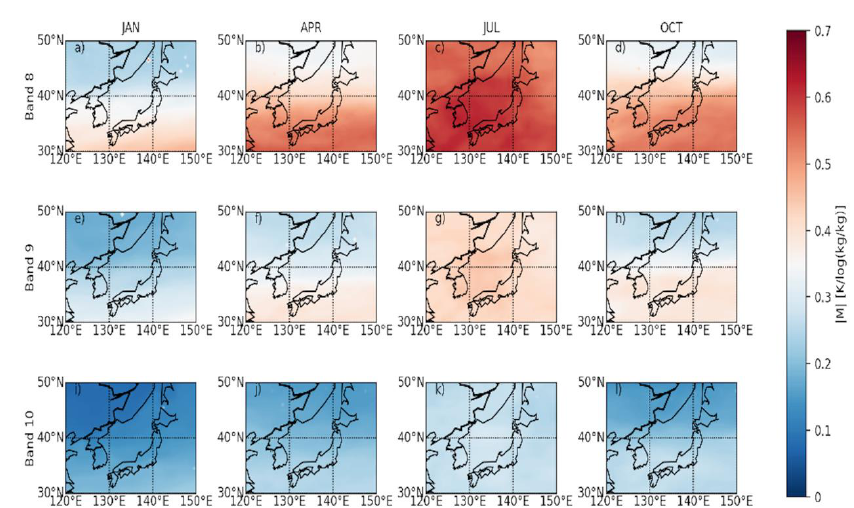
Figure 7. The mean | M | over the typical region of East Asia in January, April, July and October. ( a )–( d) are for Band 8; ( e )–( h ) are for Band 9; and ( i )–( l ) are for Band 10. Units are K/log(kg/kg).